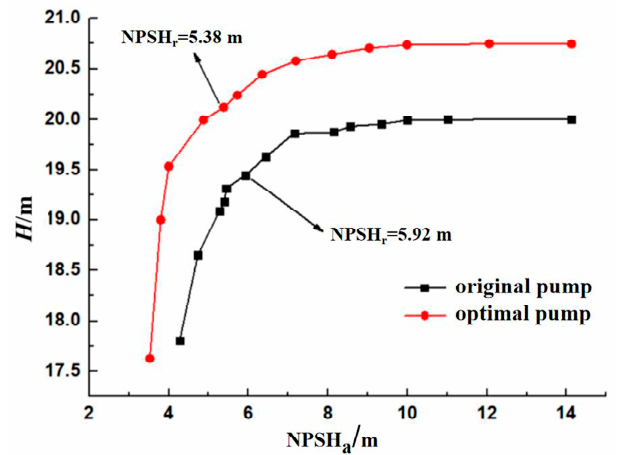
Figure 9. Cavitation performance of original pump and optimal pump.